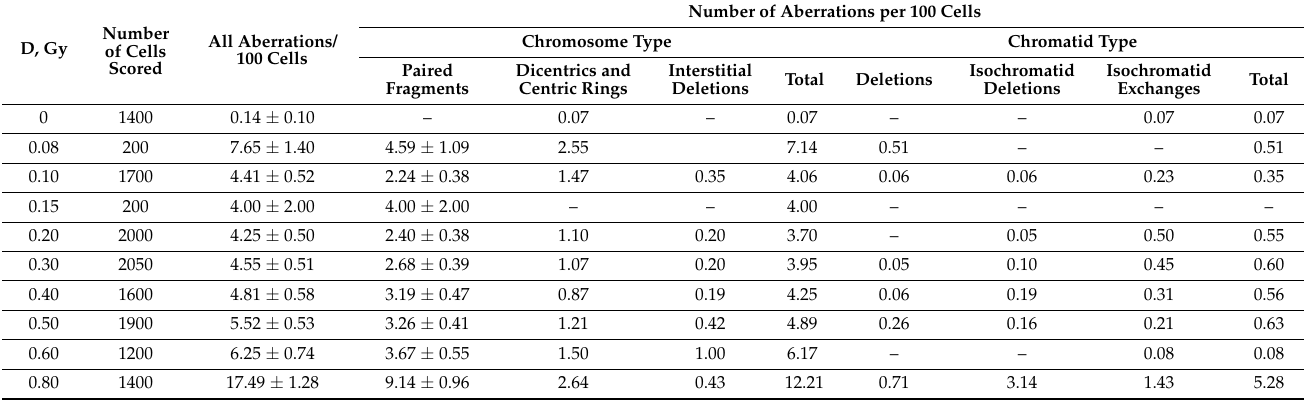
Table A1. Frequencies of chromosome aberrations induced in CHO-K1 cells by low doses of 60 Co γ